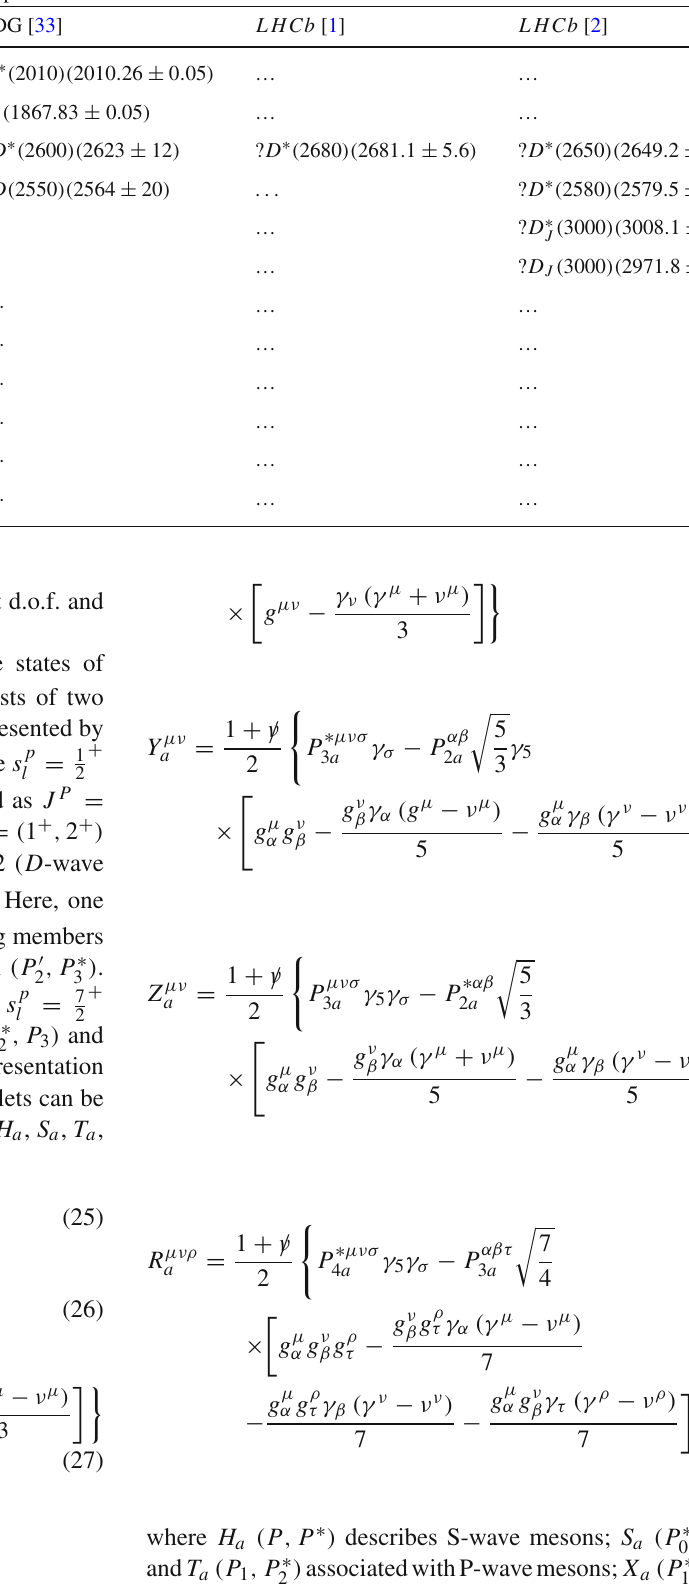
Table 5 S-wave D meson ( c ¯ q , q = u , d ) spectrum (in MeV) State ( s l J P